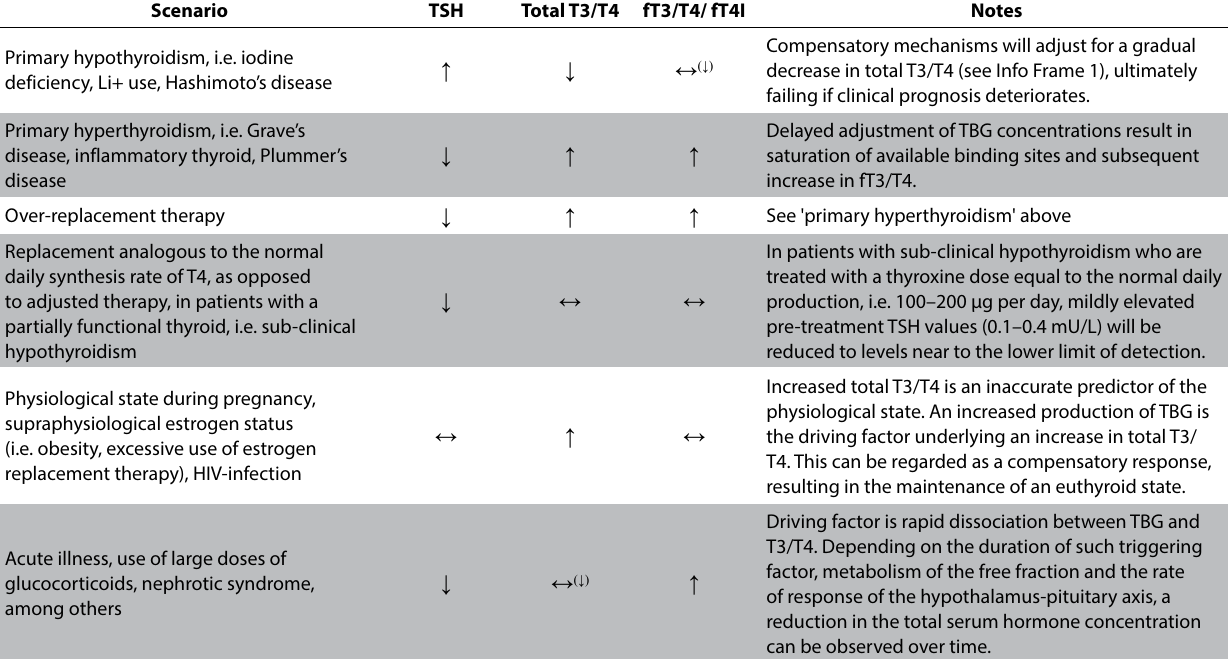
Table 1. Practical examples of expected TSH and T3/T4 levels determined by laboratory assessment